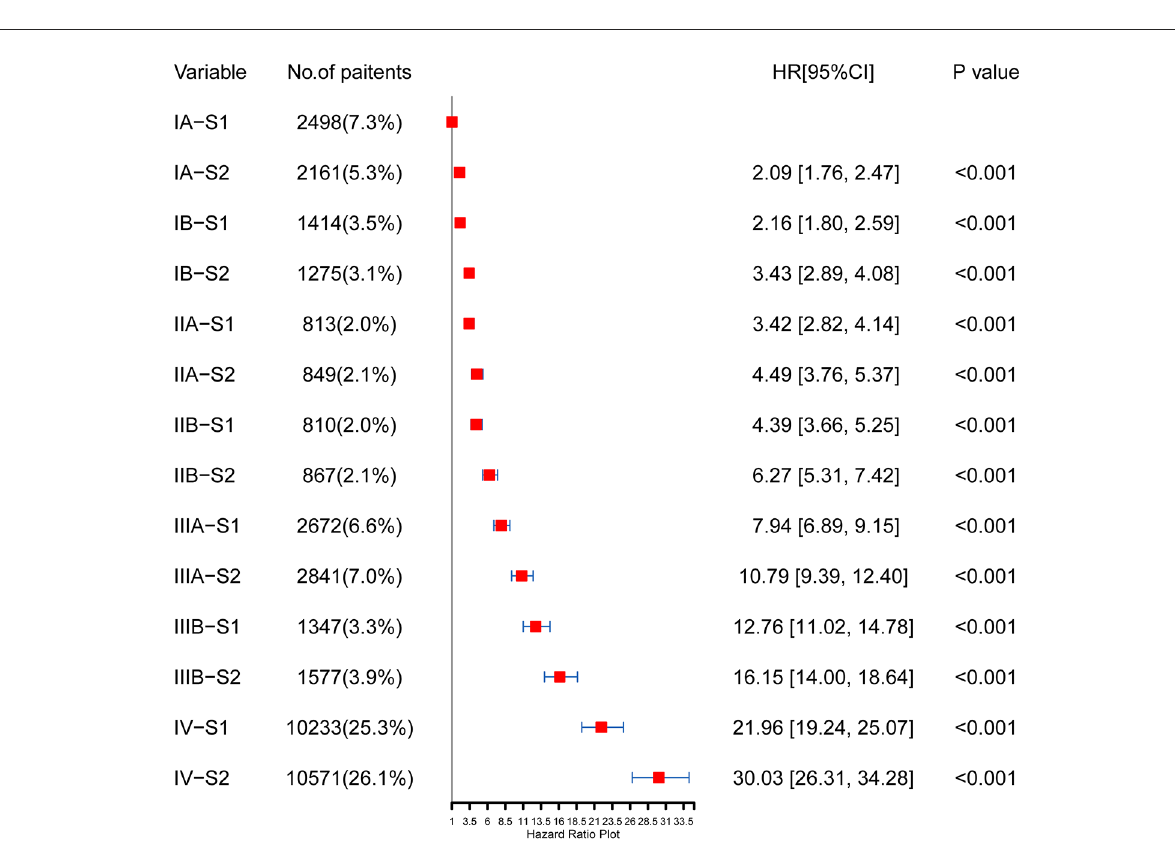
patients with NSCLC and further divided the eligible patients into two-stage (SES-1) and SES-2. Our results showed SES-2 stage was significantly associated with CSS of the